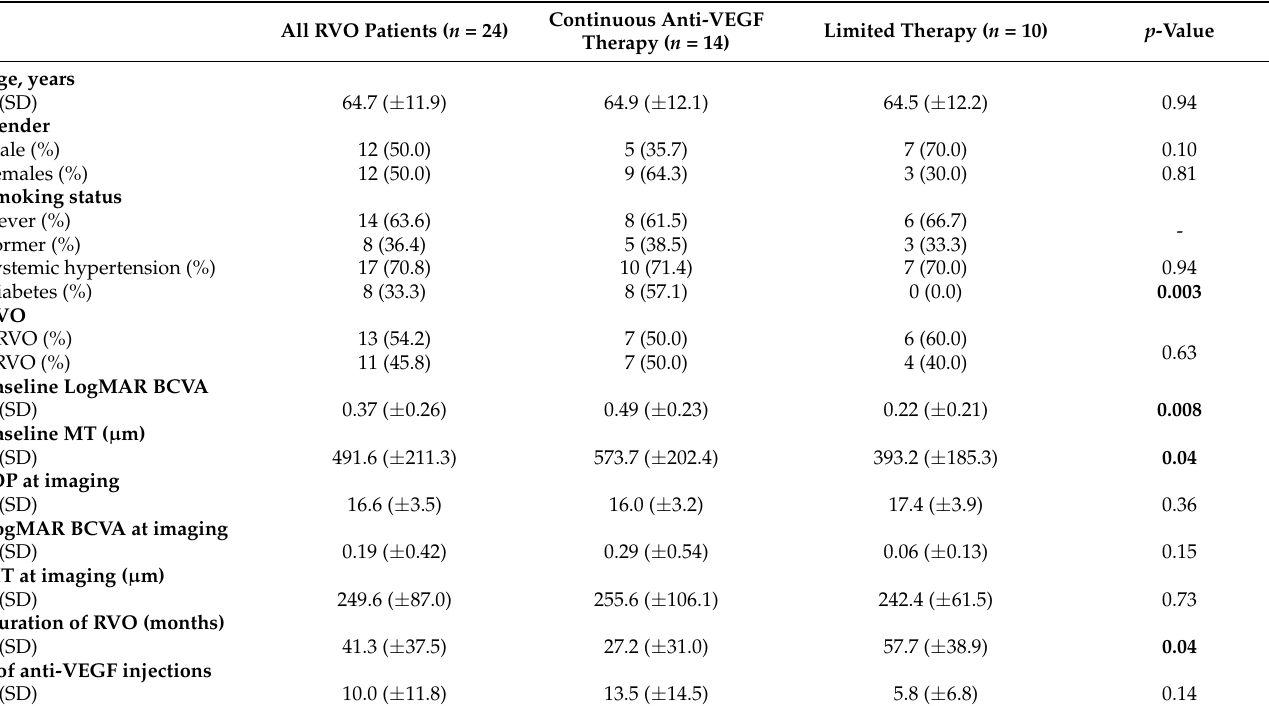
Table 1. Baseline characteristics of retinal vein occlusion patients receiving either continuous anti- VEGF therapy or limited